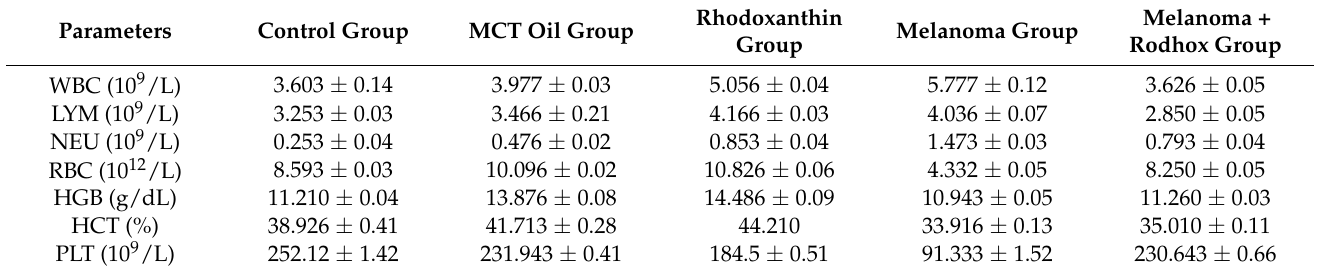
Table 1. Blood count evaluation.